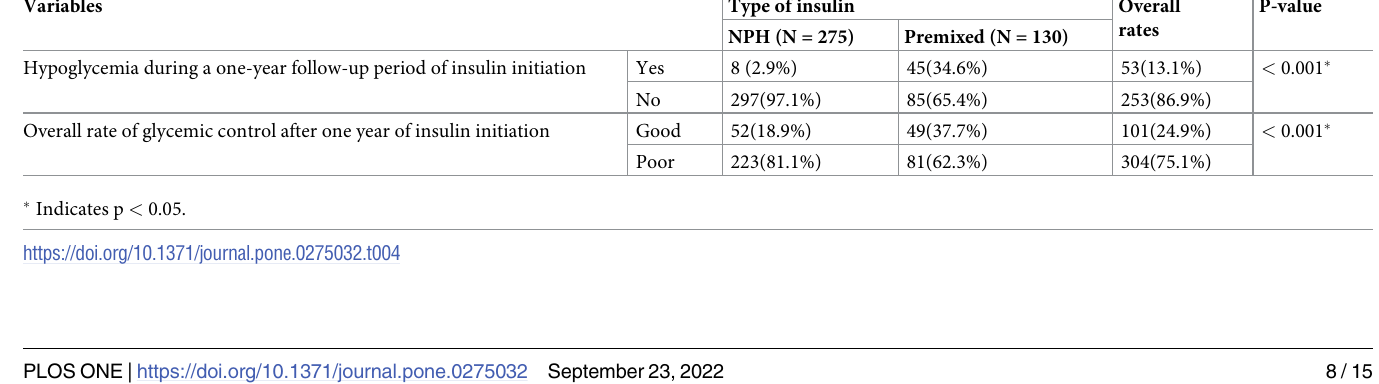
P-value rates NPH (N = 275) Premixed (N =